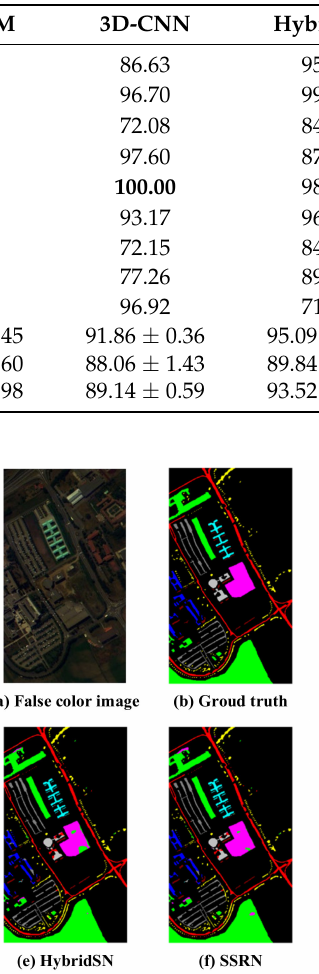
Table 9. Comparison of accuracy using the HDDA and five other methods for the PU dataset.